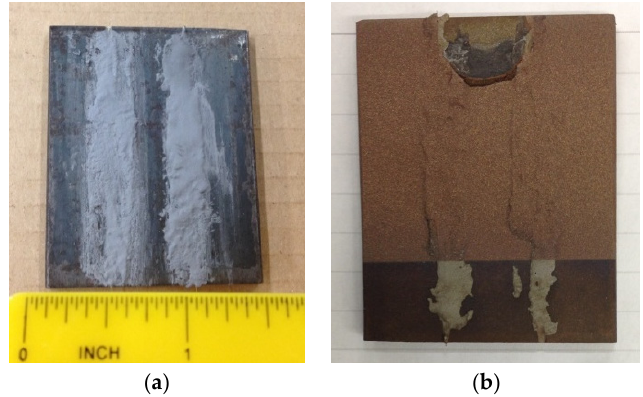
Figure 6. Example samples with attached FBG sensors ( a ) before and ( b ) after metallic coatings.